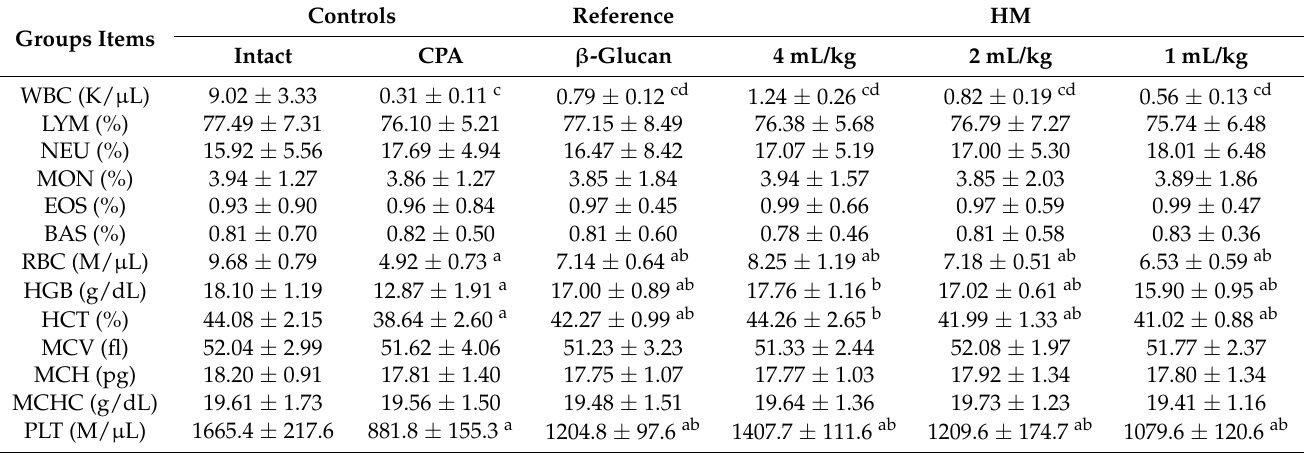
Table 2. Hematological values following hemomine treatment in intact or CPA-induced immunosup- pressed